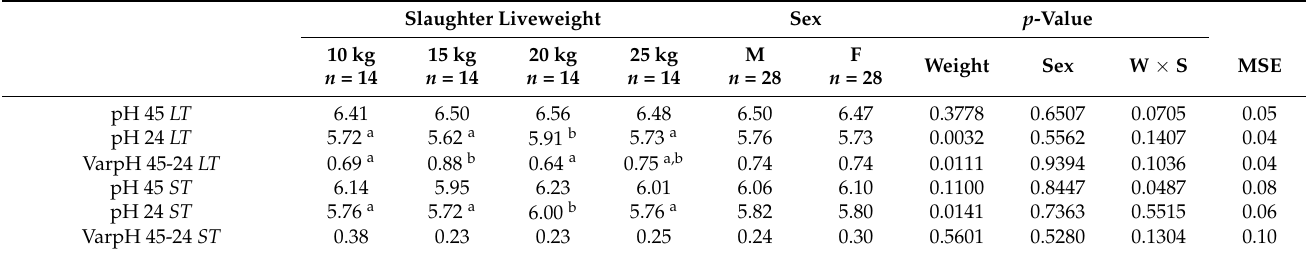
Table 1. Means and mean square errors of the pH values at 45 min and 24 h post-mortem measured at the LT and ST muscles in the four weight groups and in male and female groups. Slaughter Liveweight